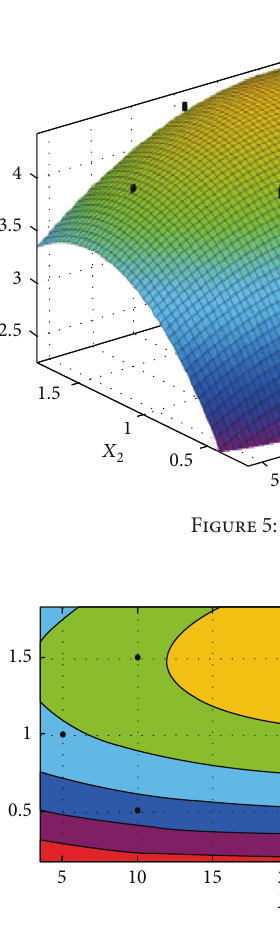
Figure 6: Contour plot for 𝑌 1 , flexural strength, and 𝑌 2 , split tensile